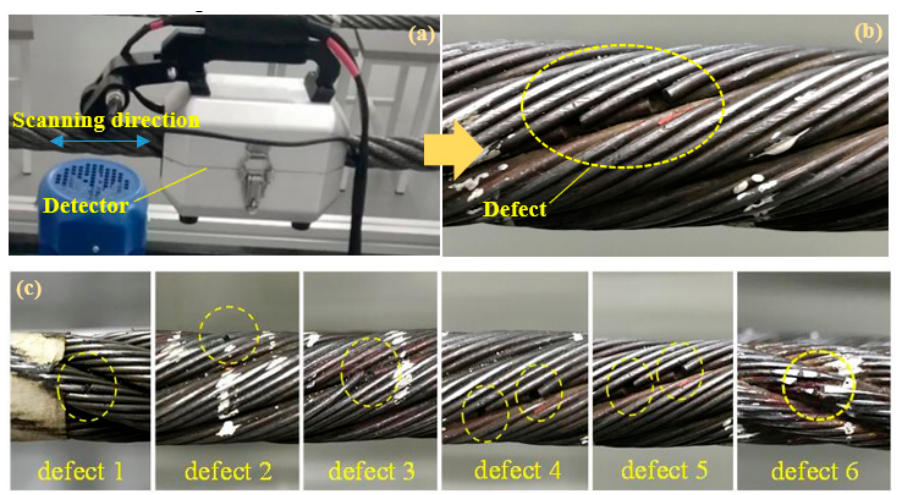
Figure 1. Wire rope testing devices and experimental defects: ( a ) wire rope detector; ( b ) wire rope defect; and ( c ) typical defect 1 to defect 6.